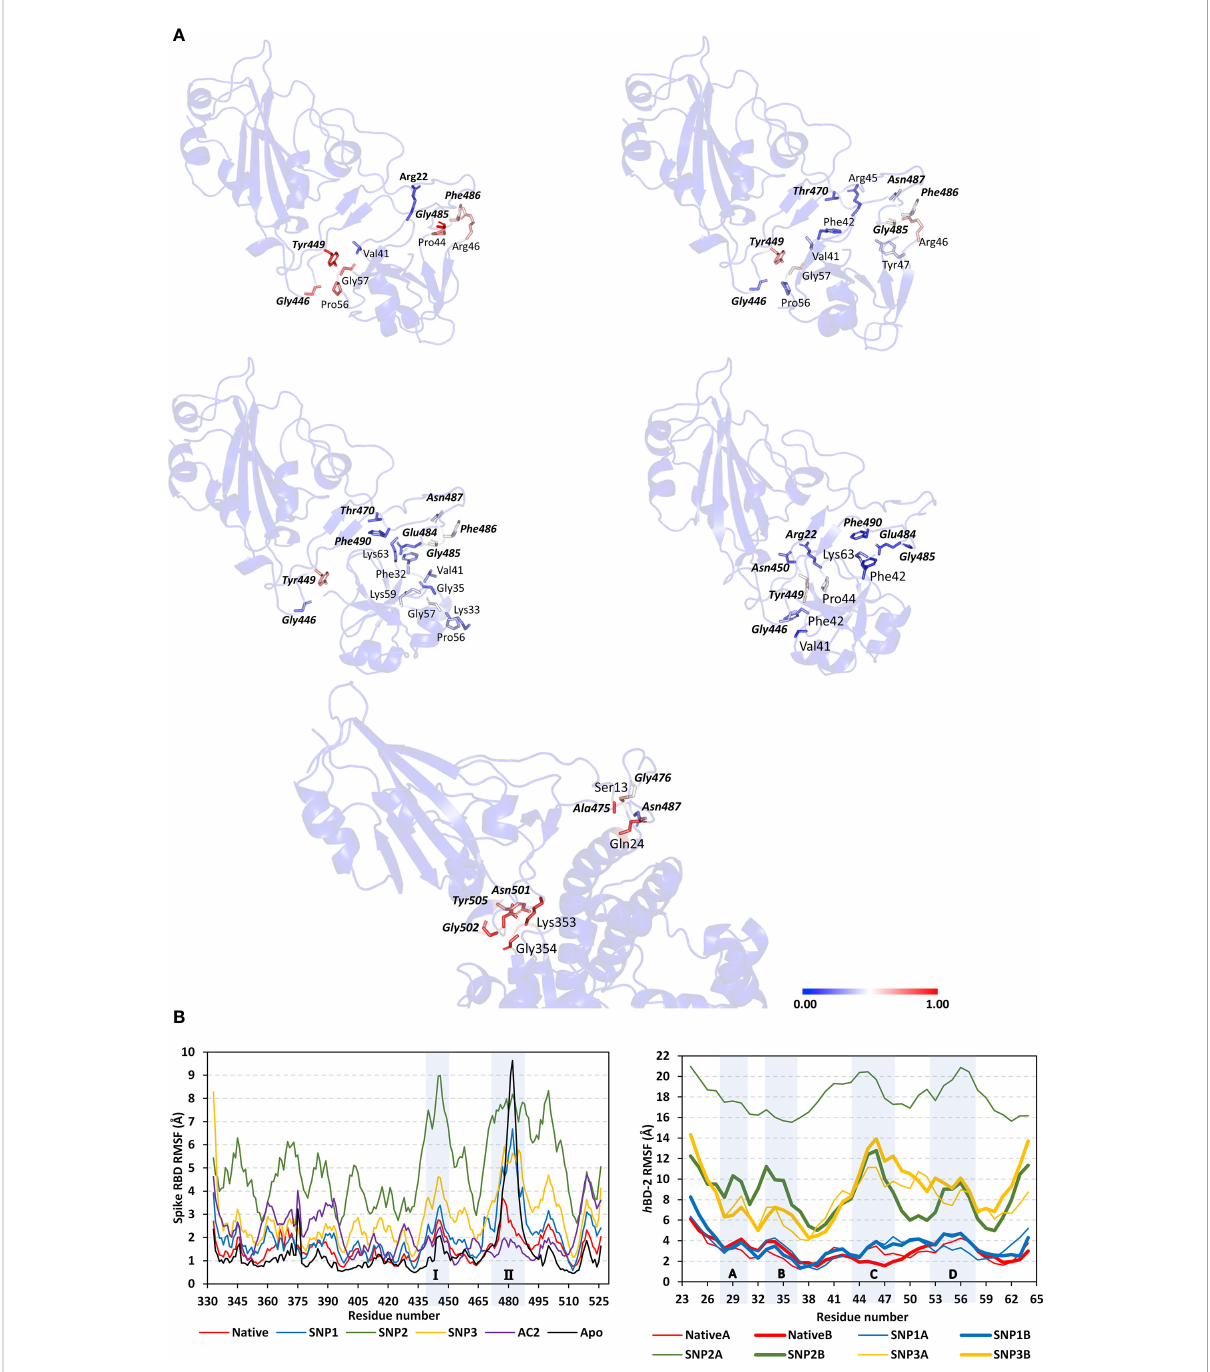
FIGURE 6 Dynamics of the simulated spike RBD/ligand complexes across the molecular dynamics simulations. (A) Per-residue contact distance occupancy analysis. Complexes of native h BD-2, SNP1, SNP2, SNP3, and h ACE2 (upper left, upper right, middle left, middle right, and bottom panels, respectively) are represented as cartoons highlighting residues (sticks) with relevant occupancies exhibiting contact distance at ≤ 5.50 Å from bound protein. Data are mapped to the residue sticks with a spectrum color bar indicating the range of 0.00 to 1.00, transitioning through 0.50 occupancies (blue, white, and red, respectively). Highlighted residues are numbered according to their respective residue sequence, while spike RBD residues are presented in bold and italic. (B) Spike RBD and h BD-2 RMSF of individual protein residues in respect to their C -alpha, as a function of the simulated times (ns). Shaded regions of spike RBD and h BD-2 residues are common regions for binding the two proteins and are thoroughly described in the above